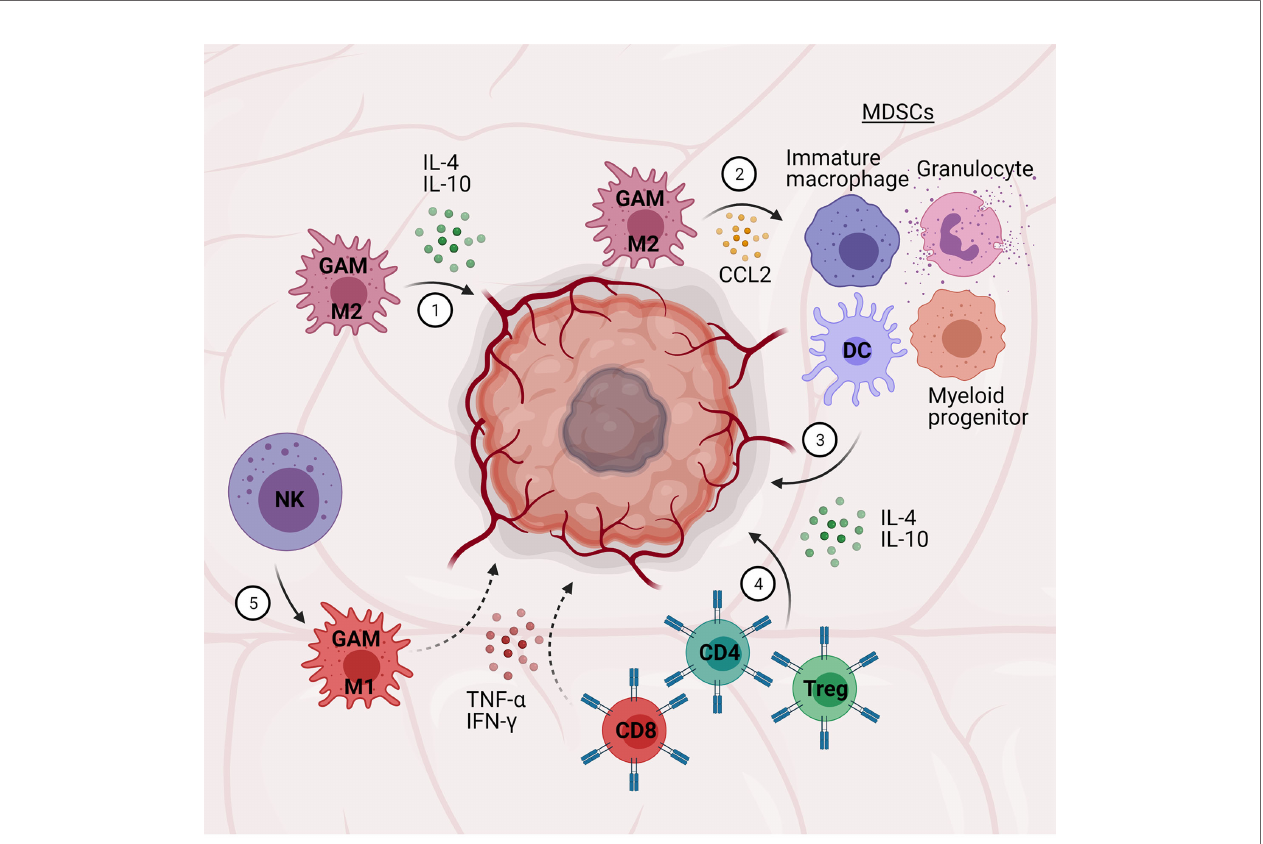
FIGURE 4 | Central-peripheral immune crosstalk in glioblastoma. (1) Glioma-associated microglia/macrophages (GAMs) adopt M2 phenotypes and secrete pro- tumor, anti-in fl ammatory factors (i.e., IL-4, IL-10). (2) GAMs secrete chemokines (CCL2) to attract myeloid-derived suppressor cells (MDSCs; immature macrophages, granulocytes, dendritic cells, myeloid progenitors). (3) MDSCs secrete pro-tumor, anti-in fl ammatory cytokines (e., TGF- b , IL-10). (4) CD4+ T cells and Tregs further contribute to a pro-tumor, anti-in fl ammatory microenvironment, while CD8+ T cells contribute to an anti-tumor environment – the relative ratio of these cells is correlated to tumor grade. (5) Natural killer (NK) cells promote pro-in fl ammatory, anti-tumor GAM